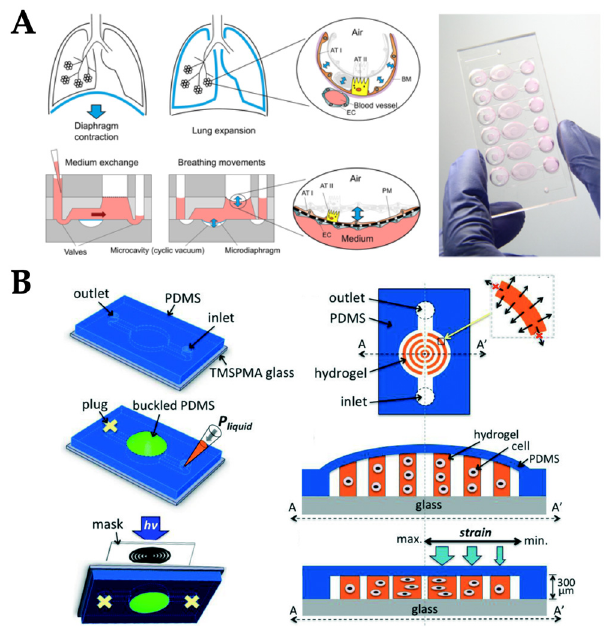
Figure 6. Examples of OOC systems with stretch and strain stimuli. ( A ) Lung-on-chip device was connected to the electro-pneumatic system to provide the negative pressure on the polydimethylsiloxane (PDMS) membrane (microdiaphragm), which subsequently generated the cyclic strain mimicking lung breathing mechanism. Reproduced with permission from Reference [44] ( B ) Gradient strain chip with a simple static strain delivery through the syringe at the inlet and PDMS plug at the outlet. Reproduced with permission from Reference